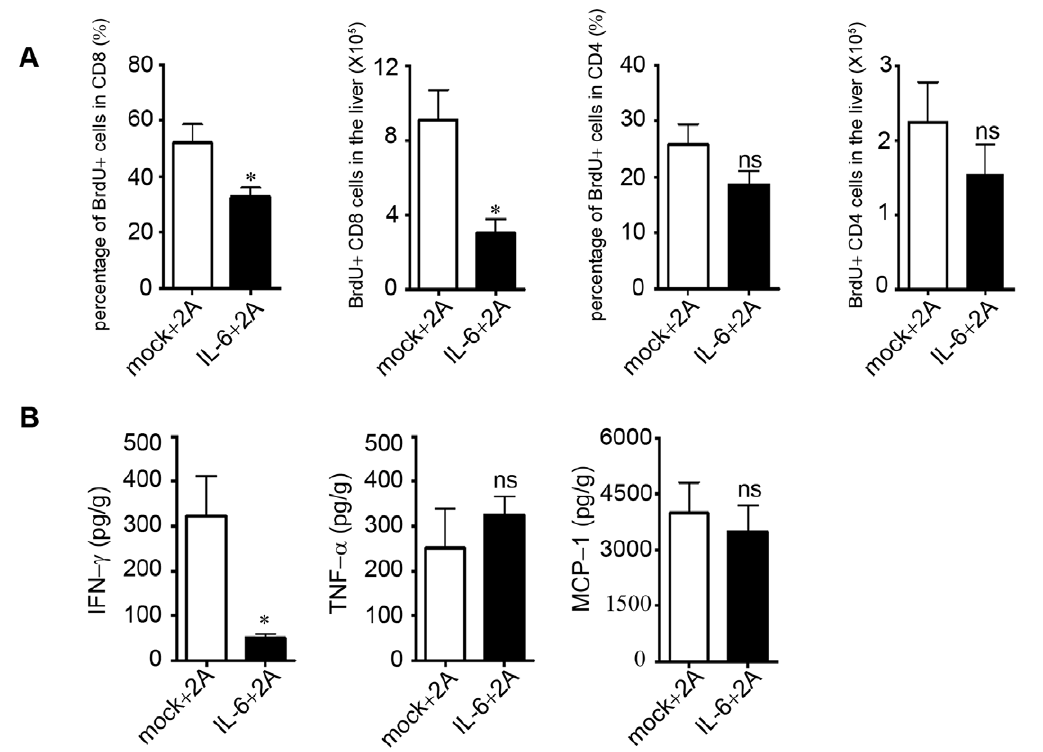
Figure 2. Proliferation and activation of CD8 + T cells were inhibited in vivo in IL-6 treated mice. C57BL/6 mice were treated with IL-6 plasmid and 2A as described in Figure 1 and further fed with drinking water containing 0.8 mg/mL of BrdU from day7 to day12. (A)At day12, the intrahepatic leukocytes were harvested and BrdU incorporation was analyzed by FACS. Percentage of BrdU + CD8 + T cells in total CD8 + T cell and total number of BrdU + CD8 + T cells in liver were shown. (B) The cytokine levels in the liver homogenate were compared. Representative data from 2 independent experiments with at least 3 mice per group is shown. *P , 0.05 in comparison with control groups.